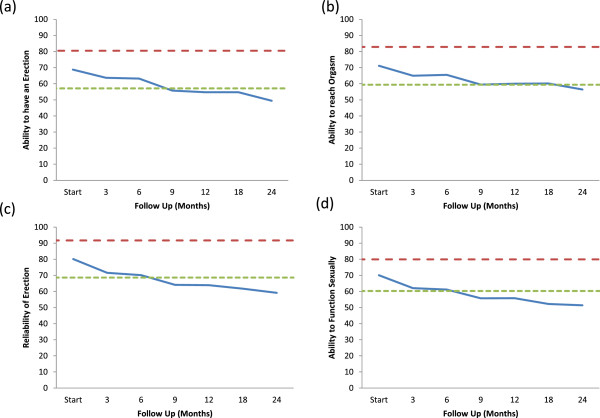
Average individual EPIC sexual function scores at baseline and following SBRT for prostate cancer. (a) ability to have an erection-Question 8A of the EPIC-26; (b) ability to reach orgasm- Question 8B of the EPIC-26; (c) reliability of erection- Question 10 of the EPIC-26; (d) ability to function sexually- Question 11 of the EPIC-26. Thresholds for clinically significant changes in scores (½ standard deviation above and below the baseline) are marked with dashed lines. EPIC scores range from 0–100 with higher values representing a more favorable health-related QOL.